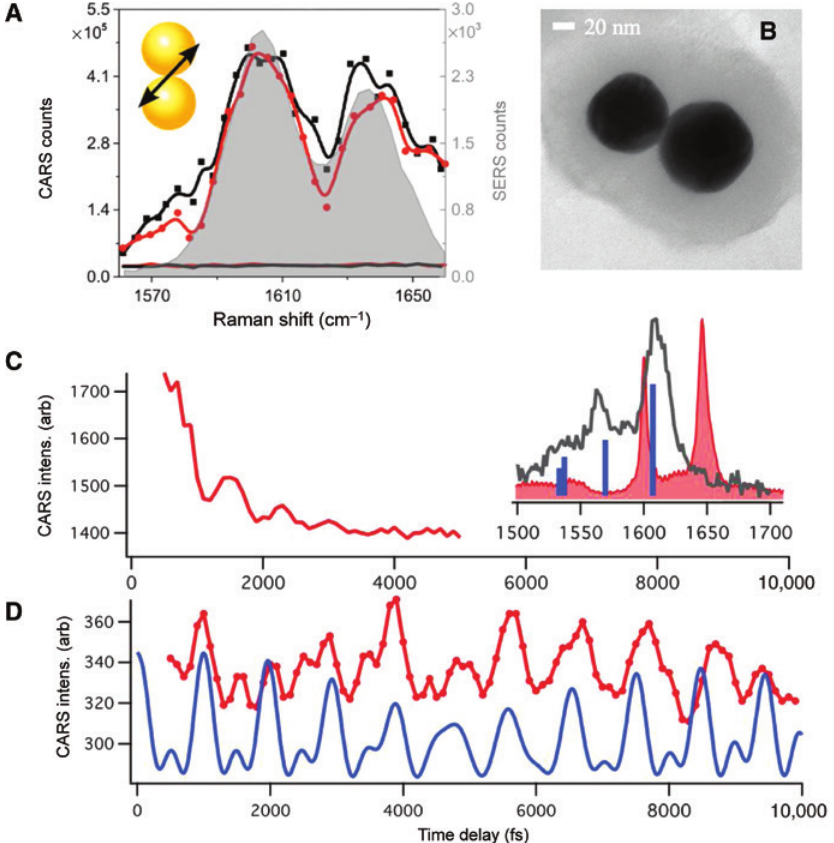
Figure 14: SE-CARS measurements of dipyridyl ethylene (BPE) on individual gold dumbbell antennas. (A) The picosecond SE-CARS of C = C stretching modes (dots). Black and red traces represent the consecutive spectral scans. The grey spectrum is the SERS signal measured on the same antenna. (B) Transmission electron microscopy (TEM) image of the gold antenna with silica coating. (C) Femtosecond time-resolved CARS from an ensemble of BPE molecules. The oscillations originate from the quantum beat of the two coherently prepared modes. (D) Time-resolved SE-CARS trace from an individual antenna equipped with BPE. The experiment (red) shows sustained quantum beats well beyond the dephasing time of the ensemble. Blue is a simulation based on the stick spectrum shown in the inset of (C). Adapted with permission from Ref.